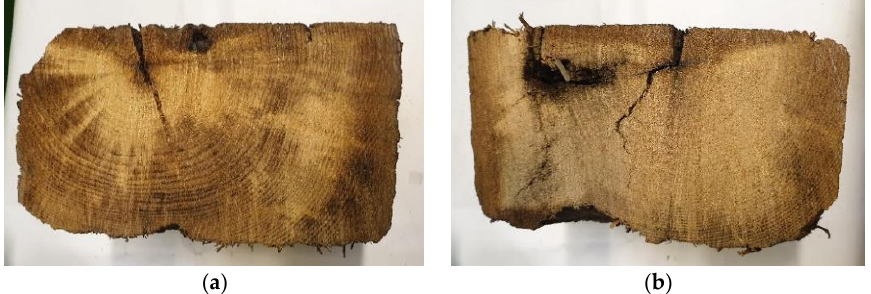
Figure 1. Cross section of the tested tie through the center of length ( a ) and 1 cm from the edge ( b ) .